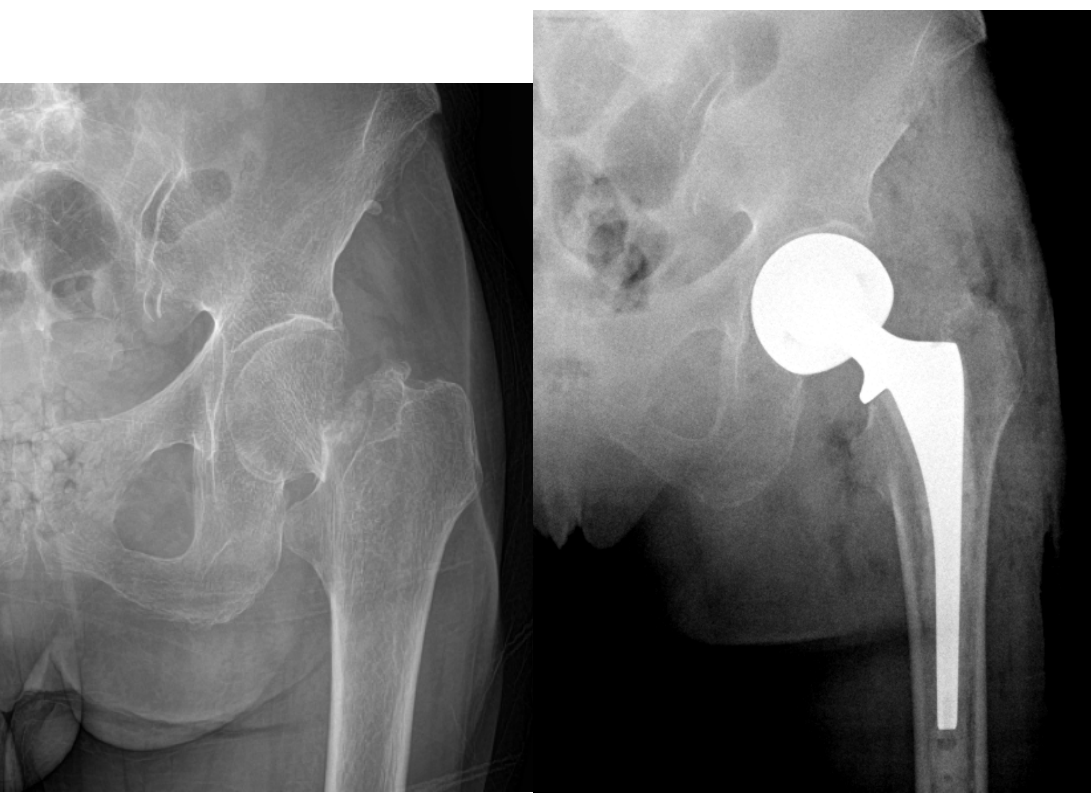
Figure 4. Example radiographs demonstrating uncemented hemiarthroplasty Garden III fracture (Left: Preoperative, right: Postoperative).